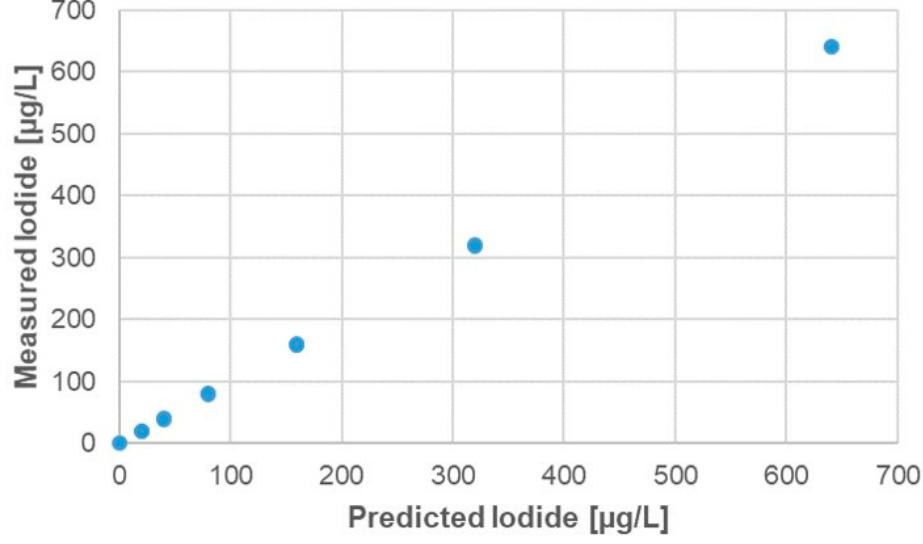
Figure 5. Measured vs. predicted (partial least square (PLS)-model) values of Iodide concentration. The root mean square error in cross validation (RMSECV) is 1.66 µg/L.